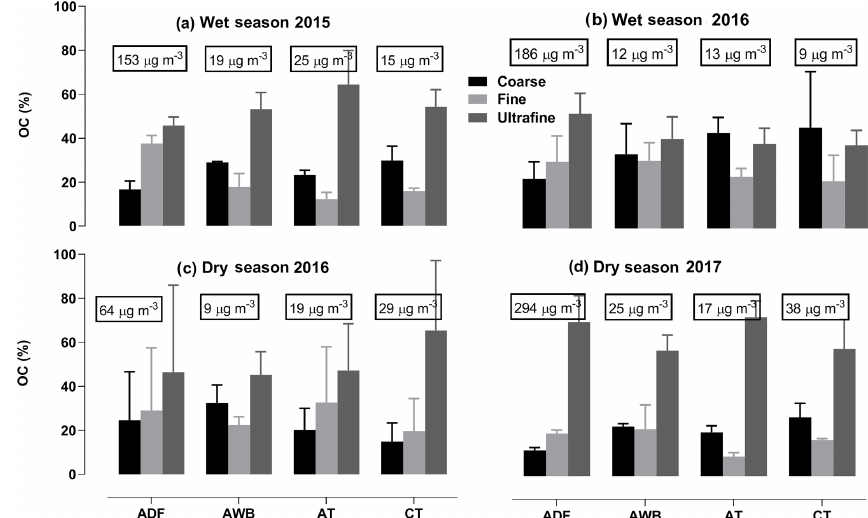
Figure 9. OC relative concentrations in each size classes (C in black, fine in light grey, ultrafine in grey) at the different study sites for each campaign. Bulk OC concentration for each site is indicated in